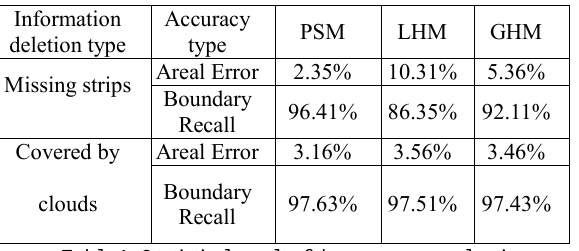
Table 1. Statistical result of the accuracy evaluation